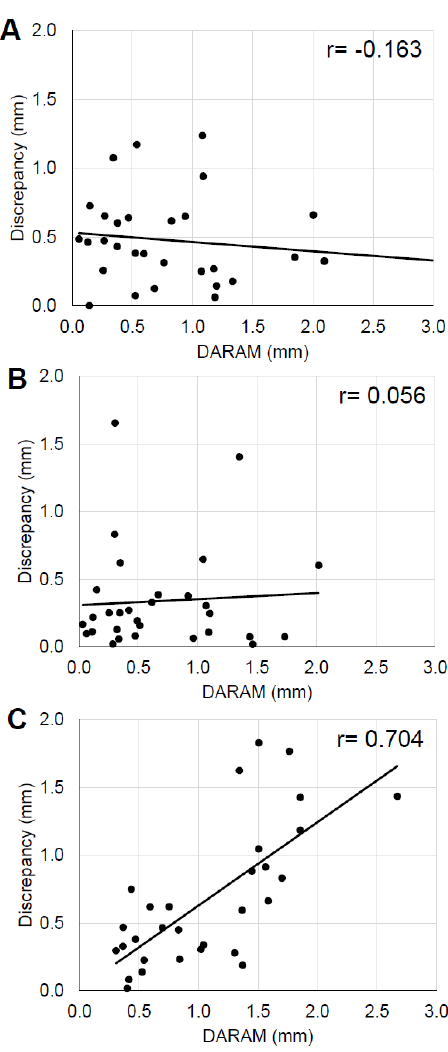
Figure 6. Correlation between the actual amount of root apex movement (DARAM) and the discrep- ancy absolute value. ( A ), X axis ( B ), Y axis, ( C ), Z